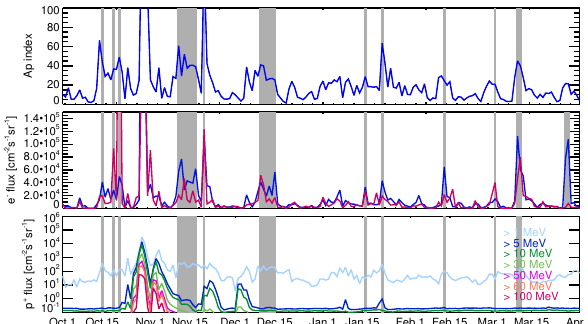
Fig.1. ProxiesforenergeticparticleprecipitationintotheatmospherefromOctober1,2003toMarch30,2004.Top:theglobalApindexasa Figure 1. Proxies for energetic particle precipitation into the atmo- proxyforgeomagneticactivity.Middle:100–300keVelectronsmeasuredbythePOESSEM/SEM-2sensorsinthe0 ◦ channel,whichlooks sphere from 1 October 2003 to 30 March 2004. Top: the global Ap upwardinpolarregions. Red: NorthernHemisphere,blue: SouthernHemisphere. Bottom: protonfluxesatdifferentenergiesmeasuredby particlesensorsontheGOES-10satellite.Markedingreyareperiodsofenhancedelectronfluxes,seetext. index as a proxy for geomagnetic activity. Middle: 100–300keV electrons measured by the POES SEM/SEM-2 sensors in the 0 ◦ channel, which looks upward in polar regions. Red: Northern Hemi- sphere, blue: Southern Hemisphere. Bottom: proton fluxes at differ- ent energies measured by particle sensors on the GOES-10 satellite. MIPAS CO, vortex, all geomag lats, [ppmv] Marked in grey are periods of enhanced electron fluxes (see